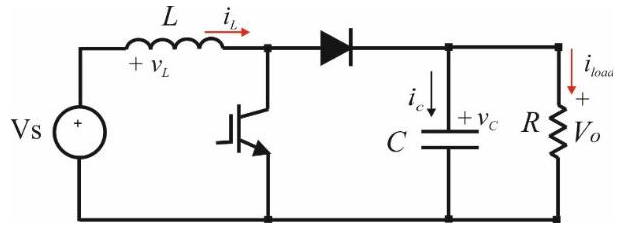
Figure 1. Boost converter representation.